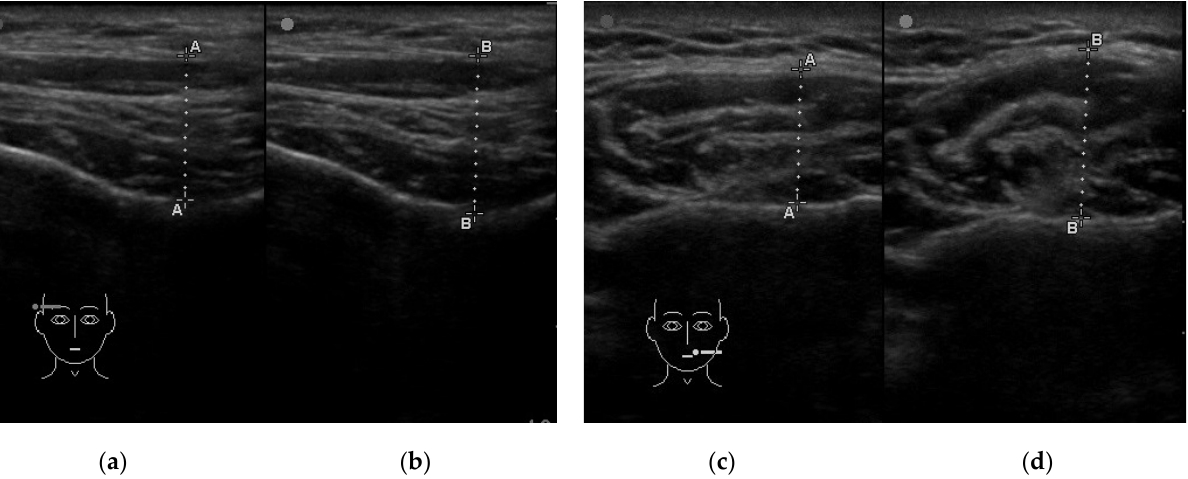
Figure 1. Example of an ultrasound examination of muscle thickness. ( a ) The temporalis muscle in the relaxed mandible position with slight contact between opposing teeth; ( b ) the temporalis muscle in the maximum voluntary clenching; ( c ) the masseter muscle in the relaxed mandible position with slight contact between opposing teeth; ( d ) the masseter muscle in the maximum voluntary clenching; line A-A—measuring line of the thickness of the muscle in the relaxed mandible position with slight contact between opposing teeth; line B-B—measuring line of the thickness of the maximum voluntary clenching.